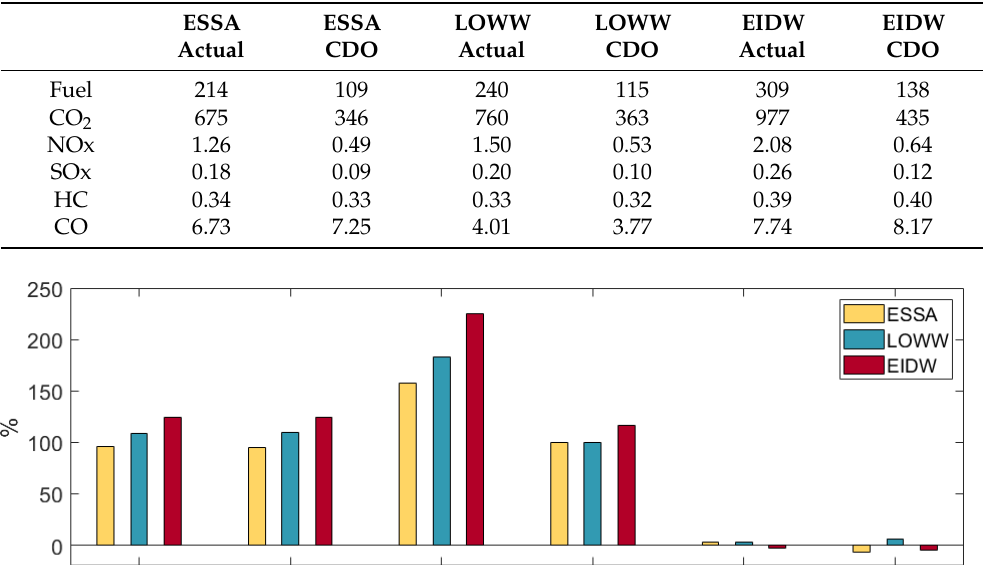
Table 3. Average fuel consumption and emissions, in TMA, per flight (in kg) for the actual flights and the corresponding reference CDOs.